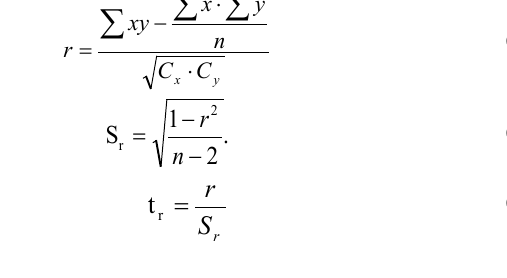
Absolute and integrated indicators of growth of young pigs of experimental groups, n = 15 Biological Indicator